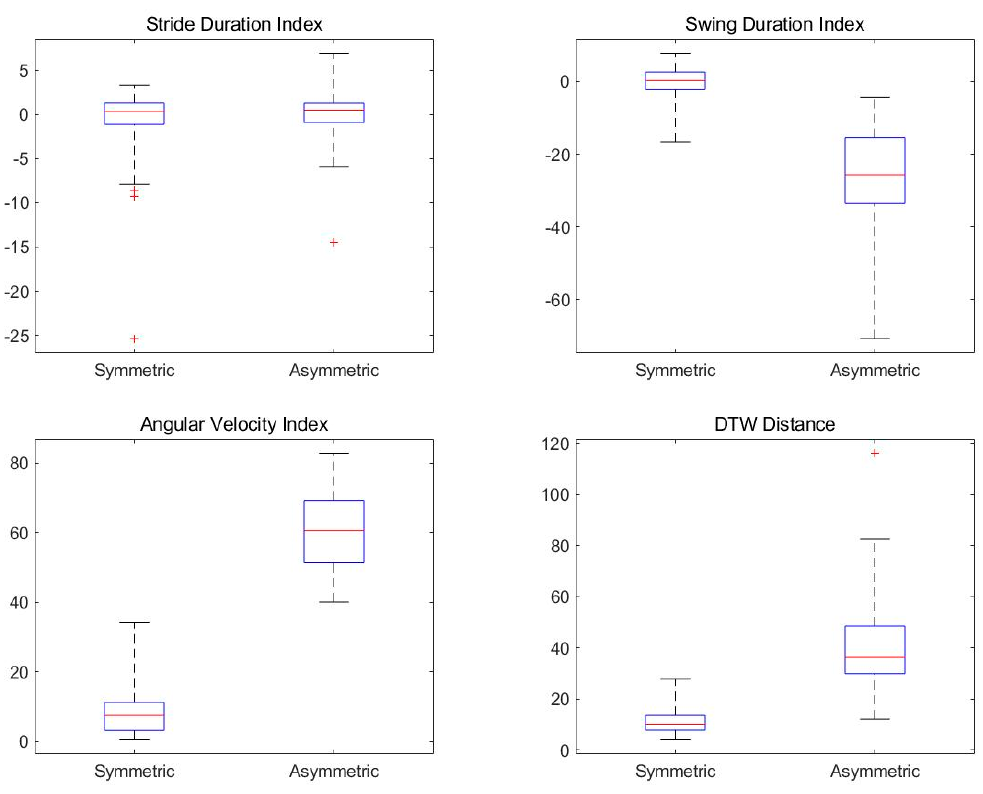
Figure 13. Comparison of results for all subjects.